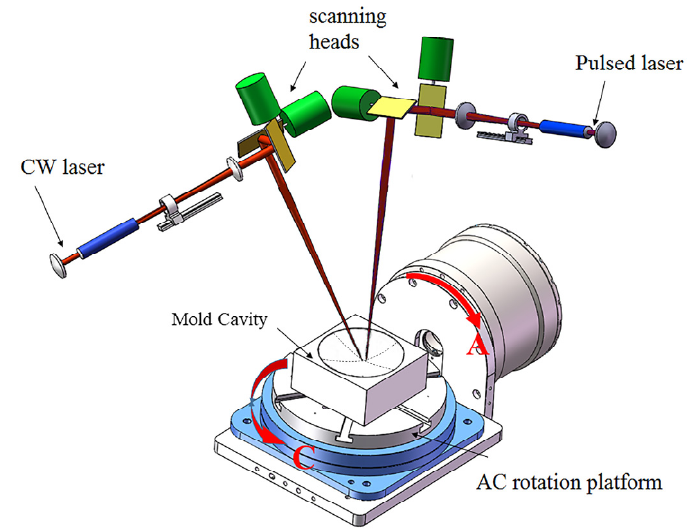
Figure 2. Dual-beam laser polishing system